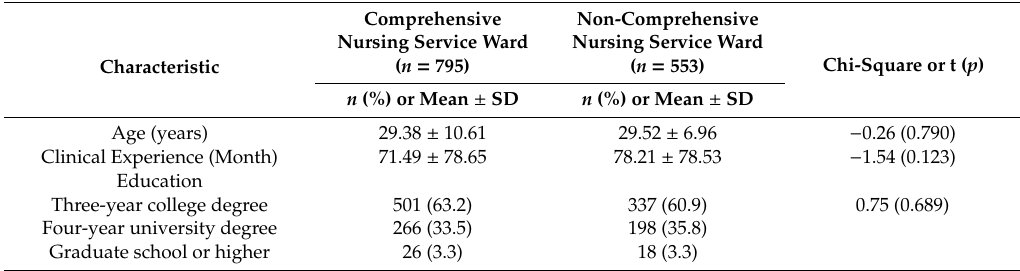
Table 1. Characteristics of Participating Nurses ( n = 1348).